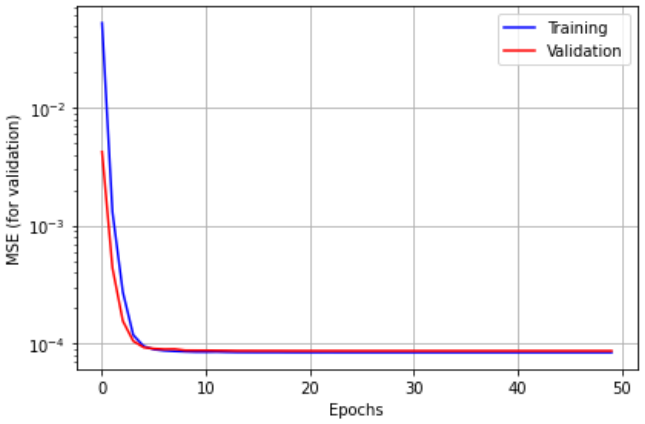
Figure 6. The MSE convergence in DNN training and validation.